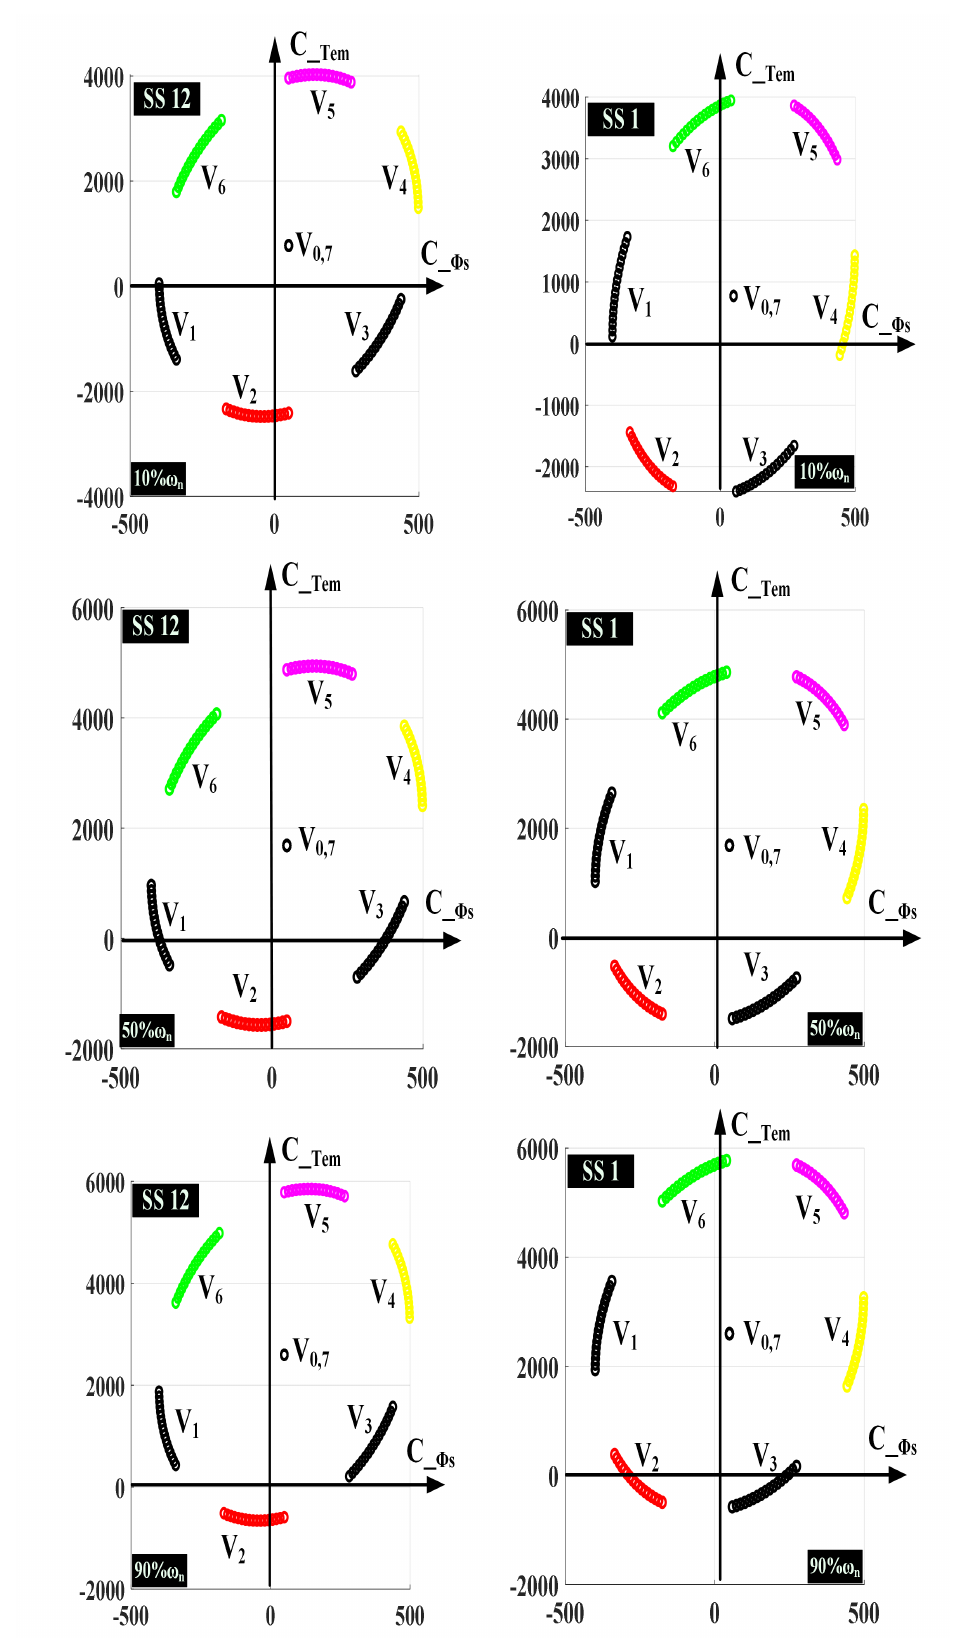
Figure 4. Effect of the voltage vectors on the error variation of both torque and stator